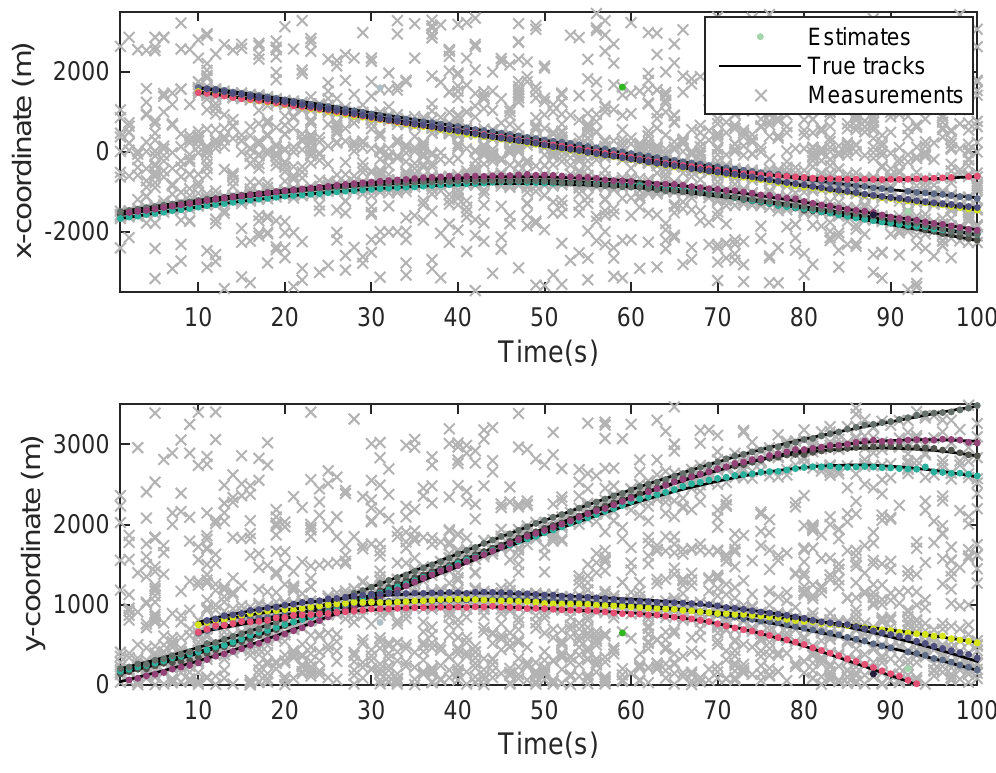
Figure 14. The state estimation by Gibbs GLMB filter for experiment 2.